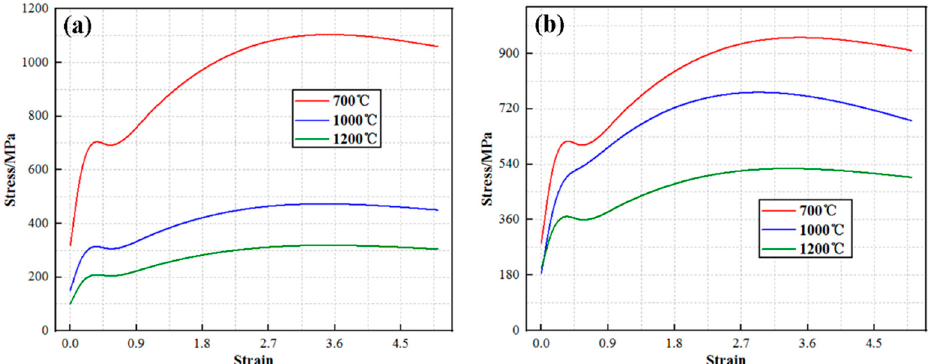
Figure 3. The stress–strain curves of AISI-1020. ( a )The strain rate is 2. ( b )The strain rate is 20. Table 1. Mechanical and thermal properties of disk workpieces. Simulation Parameters Figure 2. The numerical model of the integral forming of the large diameter thin-walled metal disk by double-roll rotary forging.